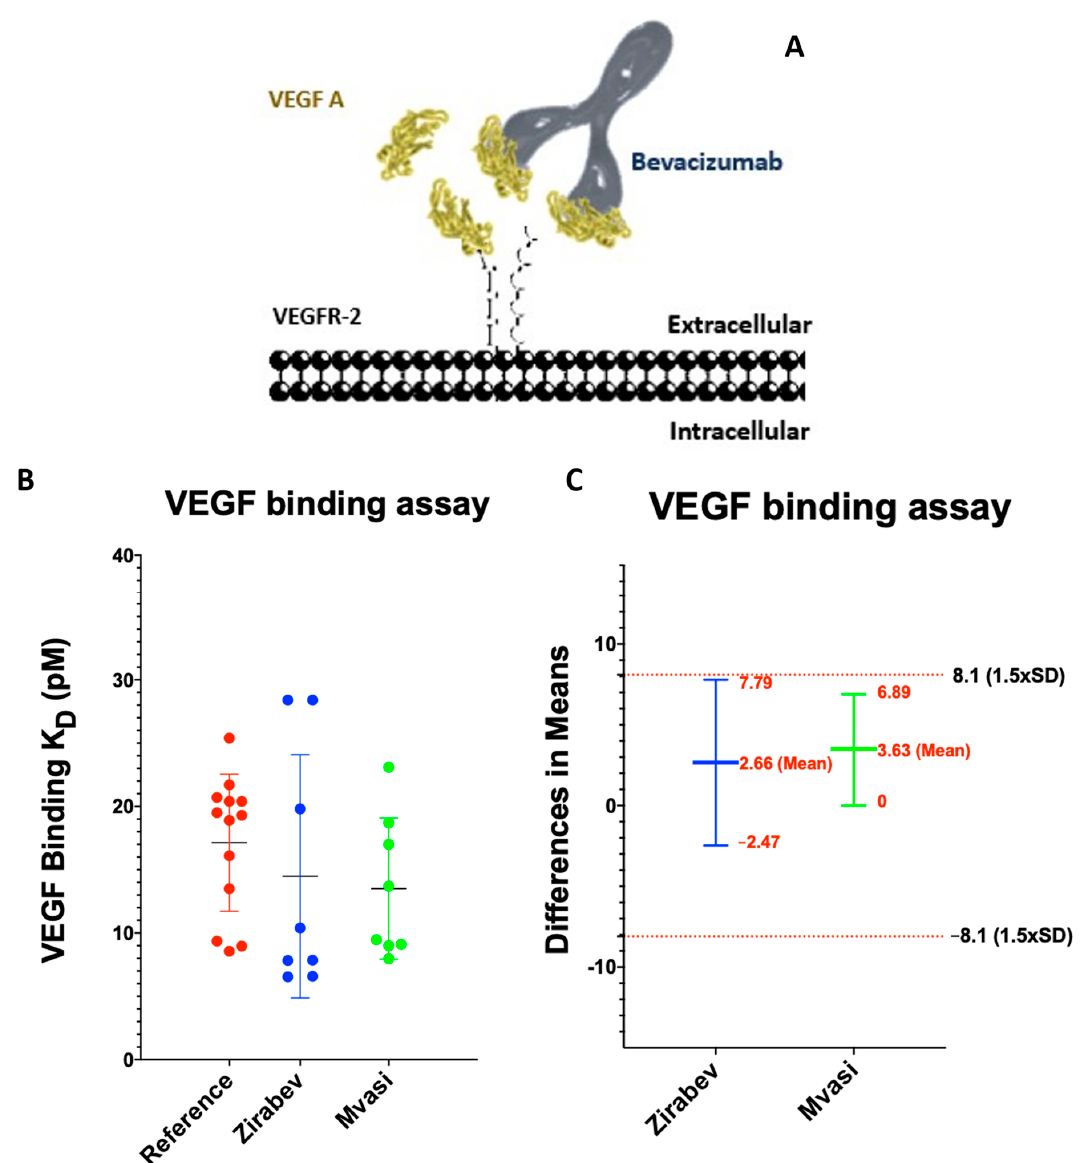
Figure 5. VEGF binding analysis of the samples ( A ) Specific interaction of bevacizumab-based monoclonal antibody drugs with free VEGF molecules in the extracellular region inhibits angiogenesis. ( B ) SPR results for VEGF binding. The data represented the mean of K D values obtained from at least 3 independent measurements. ( C ) Results of equivalency test. The Upper and lower limit was determined as mean ± 1.5 × SD.